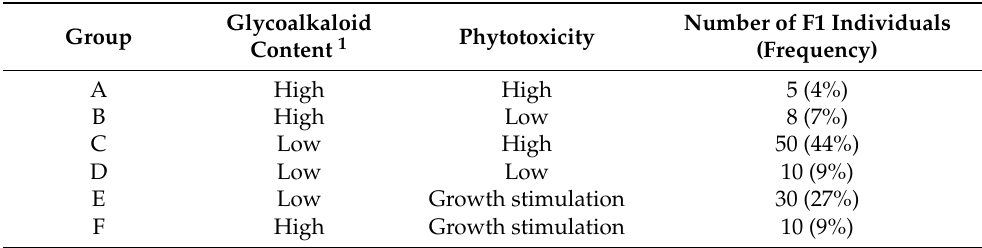
Table 2. Characteristics of groups A-F recognized in population 15–1 based on the glycoalkaloid content and phytotoxicity.